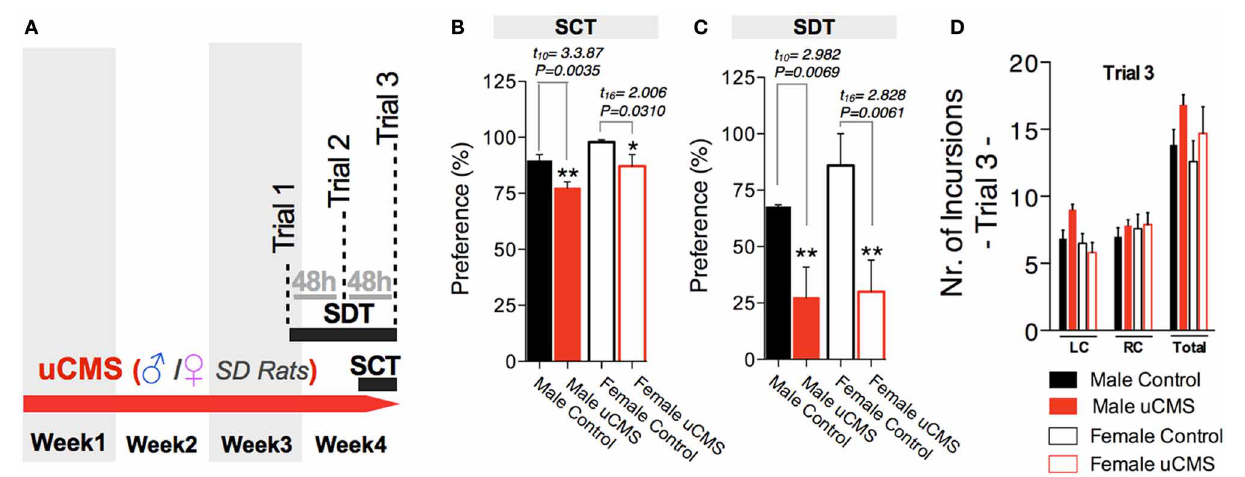
FIGURE 7 | Measuring anhedonic behavior with the Sweet Drive Test (SDT) and the Sucrose Consumption Test (SCT) in Sprague-Dawley (SD) Rats. (A) Using the same experimental approach previously used with Wistar-Han rats, male and female SD rats were tested in the SCT and the SDT. (B) uCMS exposure induced anhedonic behavior in both male and